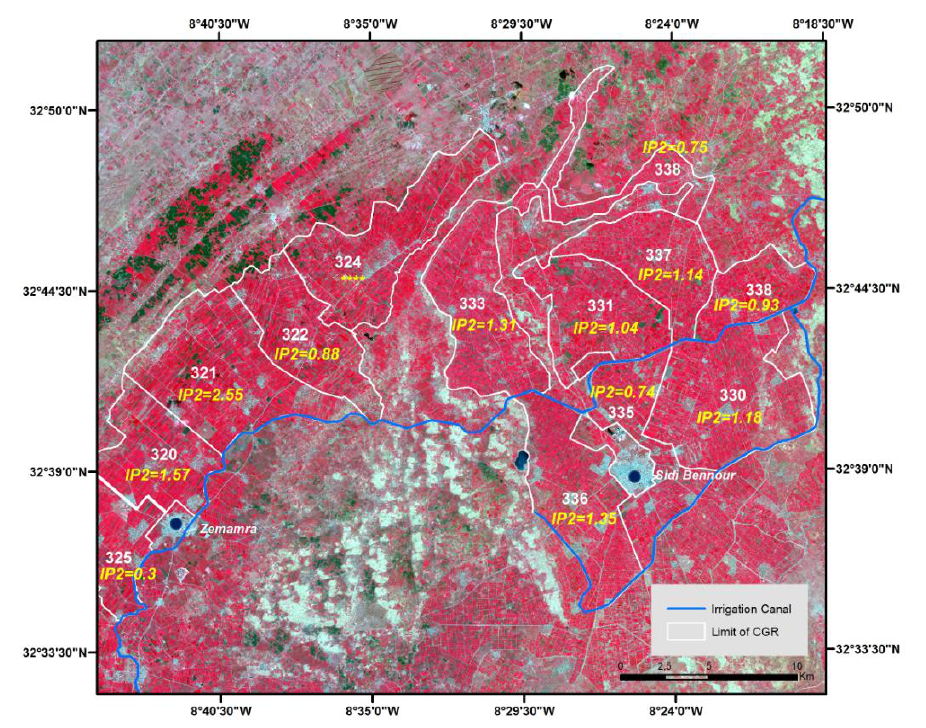
Figure 18. Distribution of IP2 per CGR for both Sidi Bennour and Zemamra districts in February 2013 using the background of RapidEye